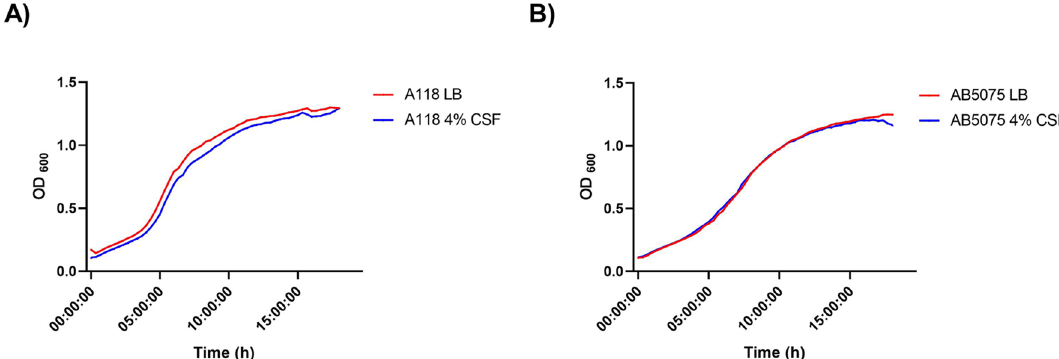
Figure 1. A118 and AB5075 growth curves in LB or LB plus 4% CSF. Strains ( A ) A118 and ( B ) AB5075 were grown in LB or LB supplemented with 4% CSF. Growth curves were conducted in independent experimental